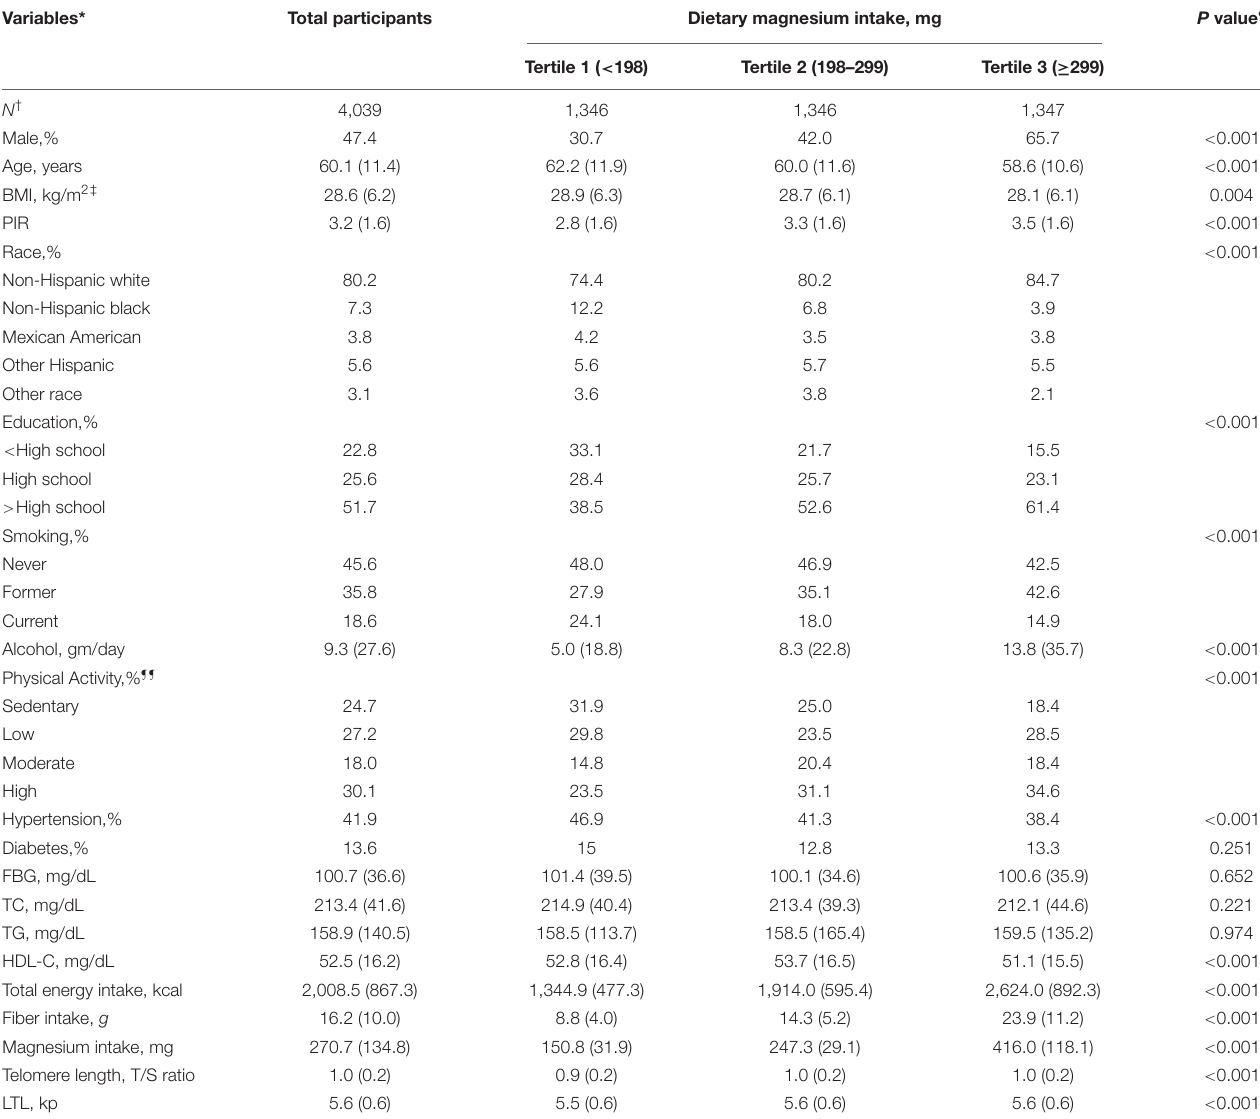
TABLE 1 | Weighted characteristics of study population based on tertiles of dietary magnesium